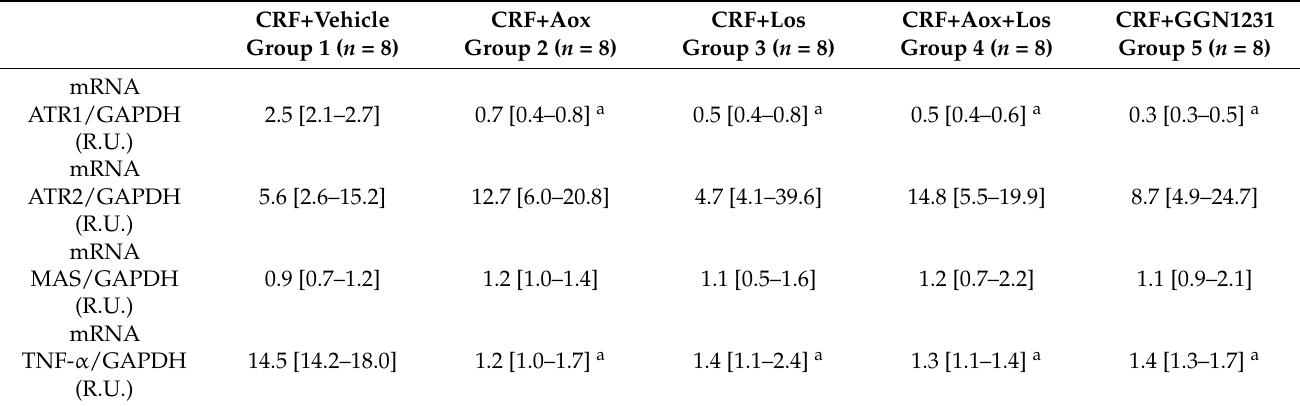
Table 4. Molecular markers of the renin-angiotensin system by quantitative